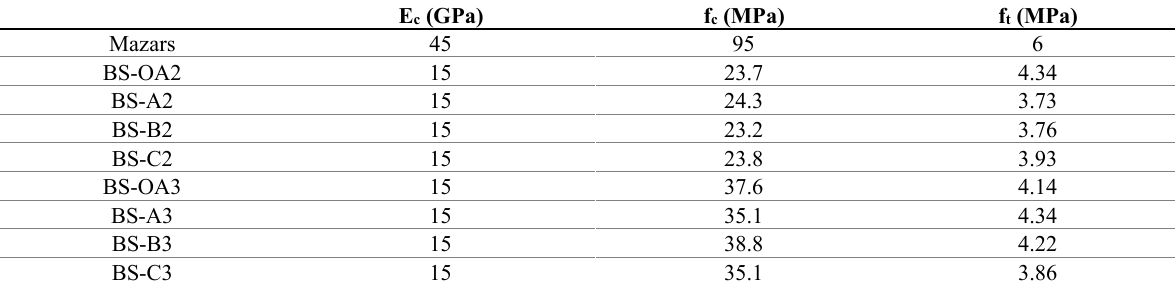
Table 2. Concrete properties.